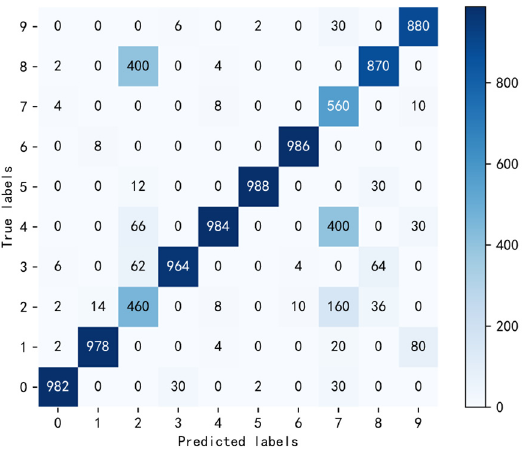
Figure 10. The classification results of samples with number = 2.